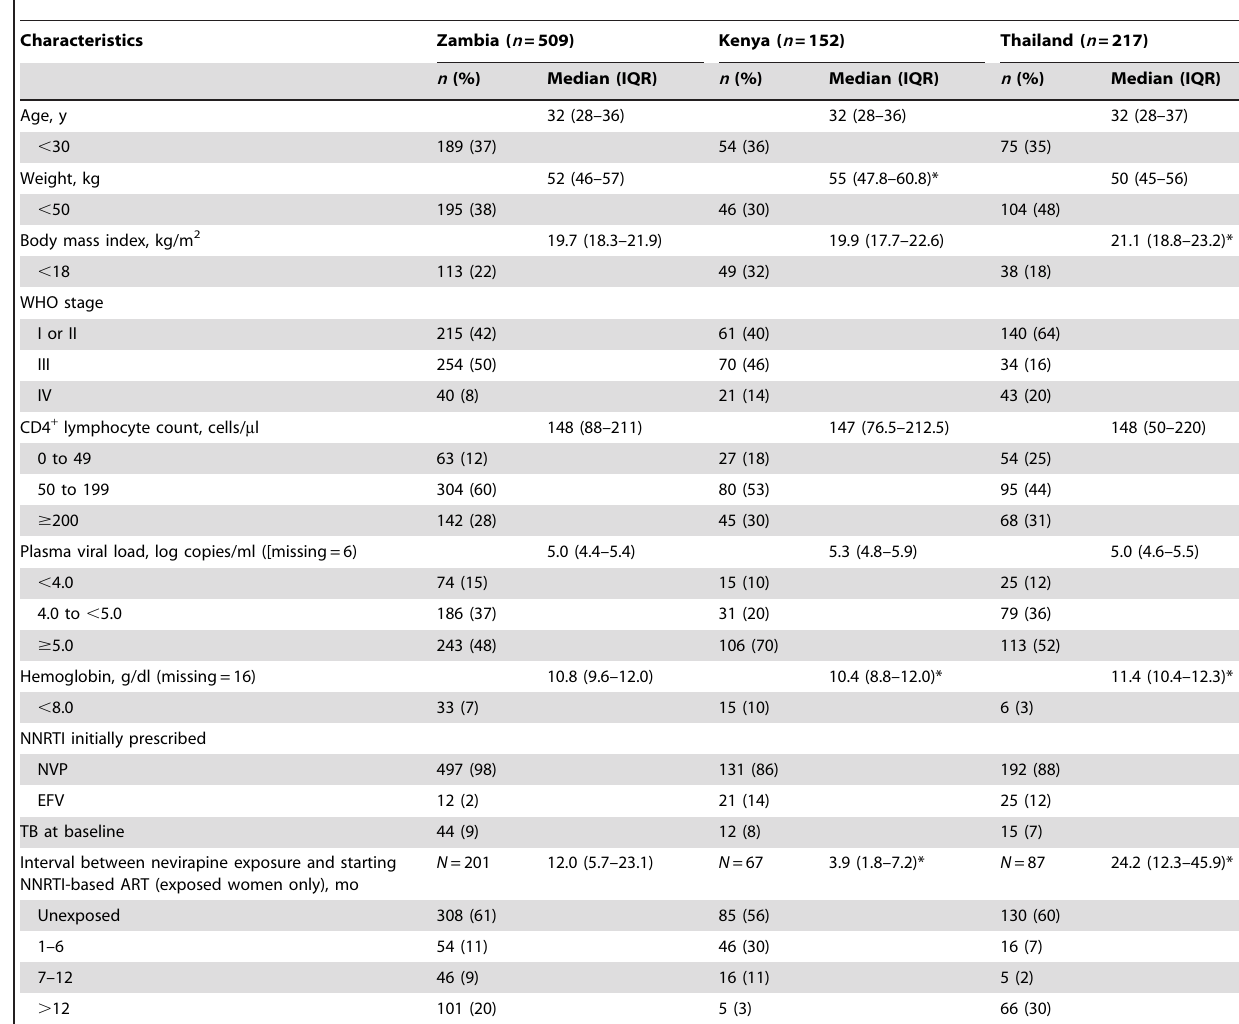
Table 1. Baseline characteristics of participants enrolled in the NNRTI Response Study—Zambia, Kenya, Thailand (2005–2008).